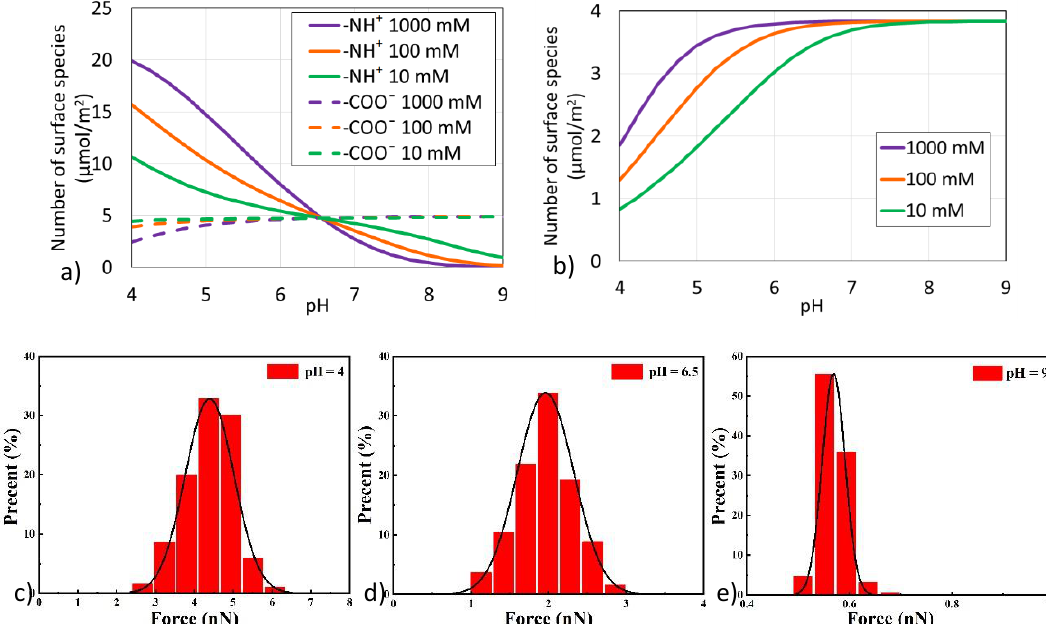
Figure 3. Effect of pH on ( a ) Number of surface species at asphaltene surfaces and ( b ) Number of surface species at silica surfaces in the presence of various salinities, and Adhesion forces of asphaltene-brine-silica systems in the presence of 100 mM NaCl at ( c ) pH 4, ( d ) pH 6.5, and ( e ) pH